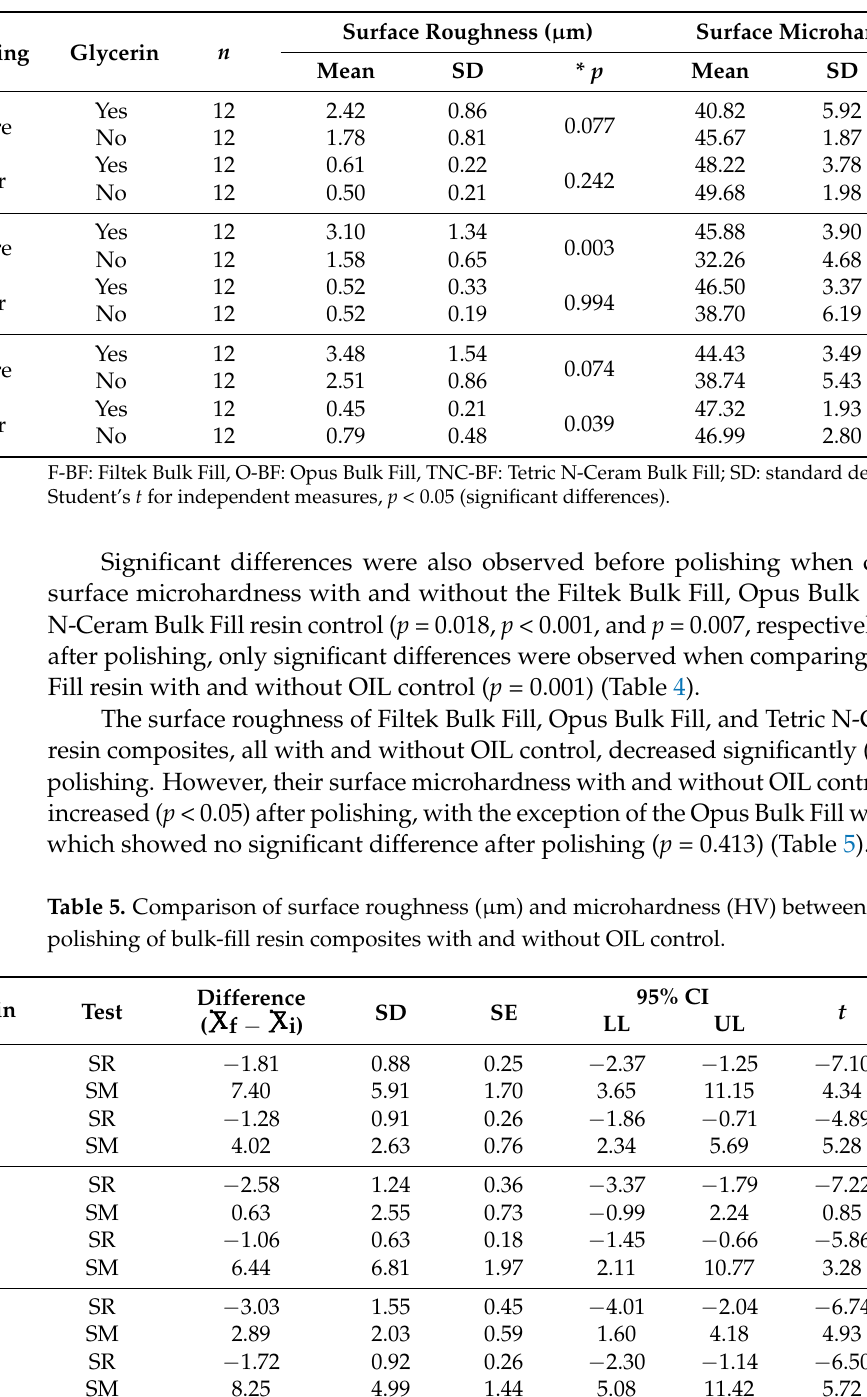
SR: surface roughness; SM: surface microhardness; F-BF: Filtek Bulk Fill, O-BF: Opus Bulk Fill, TNC-BF: Tetric N-Ceram Bulk Fill; G: with glycerin; Ⴟ f: mean after polishing; Ⴟ i: mean before i: mean before polishing; SD: standard deviation; SE: standard error polishing; of mean; 95% CI: 95% confidence interval, LL: lower limit, UL: upper limit; * based on Student’s t for